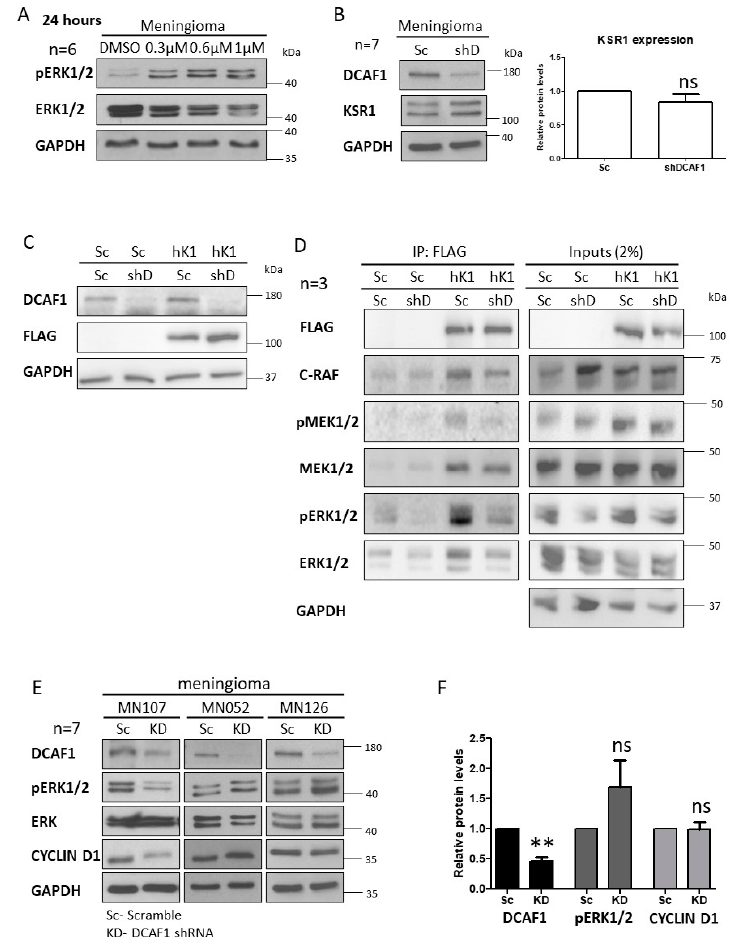
Figure 4. Raf / MEK / ERK activity is enhanced after MLN3651 treatment or DCAF1 knockdown in meningioma. ( A ) Western blot analysis of three primary meningioma (MN) treated with DMSO, 0.3 µ M, 0.6 µ M or 1 µ M MLN3651 for 24 hours, and probed for pERK1 / 2, ERK1 / 2 and GAPDH (loading control; n = 6); ( B ) Representative Western blot of DCAF1 and KSR1 expression after DCAF1 knockdown. Scramble (Sc) or DCAF1 (KD) lentivirus was added to cells followed by seven days of puromycin selection before cell lysis ( n = 7). The graph shows the mean KSR1 expression with standard error of the mean (SEM) in shDCAF1-treated MN cells normalised to the loading control, GAPDH and relative to Scramble, ns—not significant; ( C ) DCAF1 expression was targeted with a shRNA lentiviral plasmid in HEK293T cells, and then human KSR1 (hK1) with a FLAG tag was overexpressed; ( D ) Western blot shows immunoprecipitated FLAG complexes and input lysates probed with FLAG, C-RAF, pMEK1 / 2, MEK1 / 2, pERK1 / 2. ERK1 / 2 and GAPDH, representative of three repeats. FLAG tag interacting proteins were immunoprecipitated from Scramble (Sc) / Sc and Sc / DCAF1 knockdown (shD) lysates as a negative control. Input lysates show endogenous expression in lysates prior to the immunoprecipitation (2% volume); ( E ) Western blots of DCAF1, pERK1 / 2, ERK1 / 2 and CYCLIN D1 expression after Scramble (Sc) or DCAF1 knockdown (KD) in three meningioma (MN) representative of seven replicates; ( F ) Mean DCAF1, pERK1 / 2 and CYCLIN D1 expression and SEM in shDCAF1-treated MN cells normalised to the loading control, GAPDH and relative to Scramble. (** p < 0.01, ns: not significant, p > 0.05). The whole western blot image please find in Figure